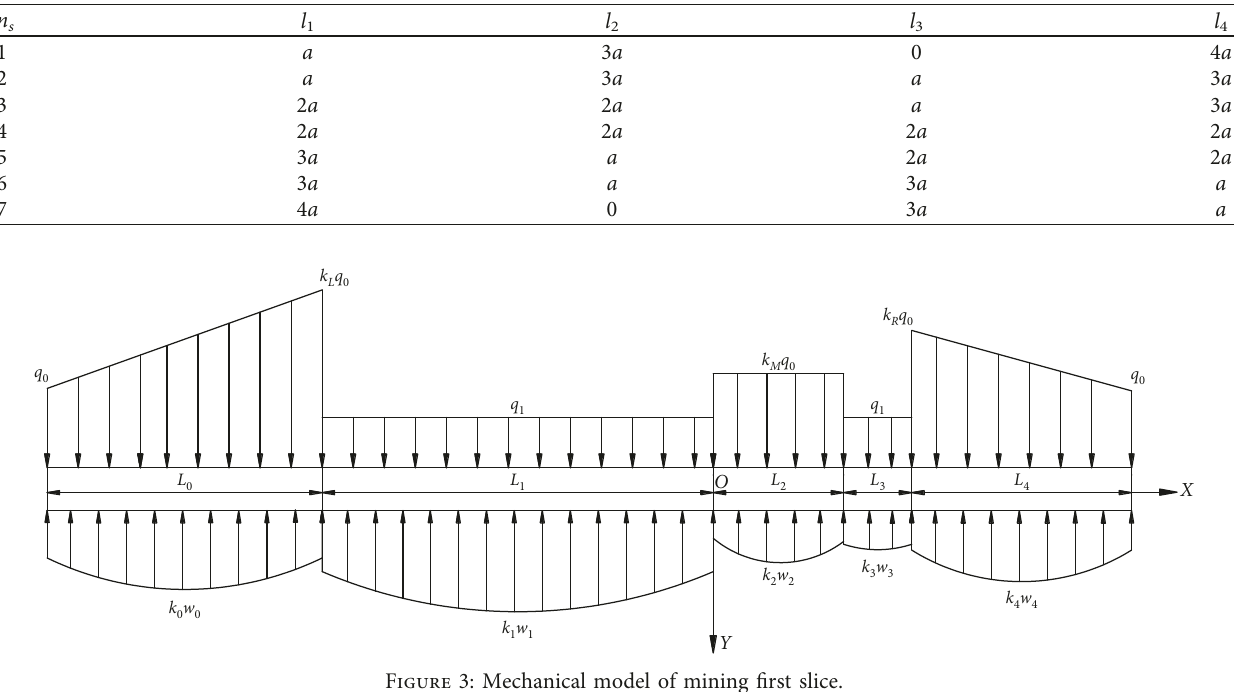
Figure 2: Diagram of the foundation structure for mining the first slice. Table 1: The foundation structure of different excavation steps in a mining cycle.